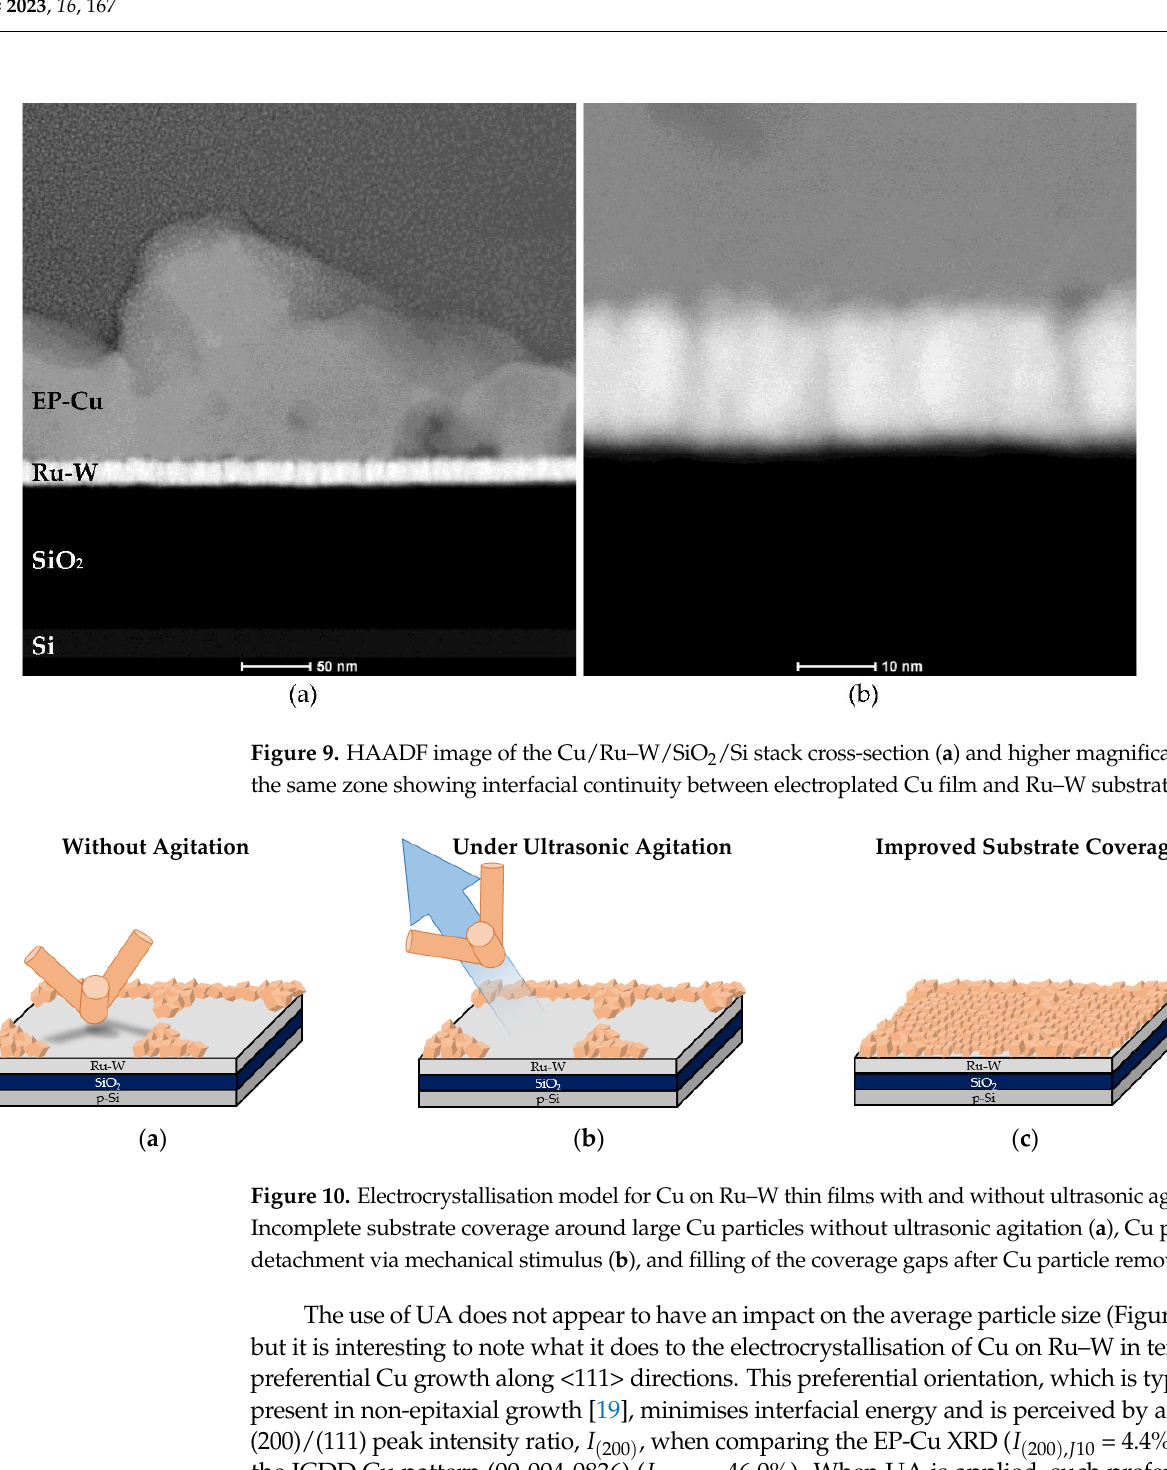
Figure 8. Digital optical microscopy images of the as-deposited Cu film obtained at 10 mA·cm −2 without agitation ( a ) and under ultrasonic electrolyte agitation ( c ). The same films observed at higher magnification by SEM in ( b ) and ( d ), respectively.